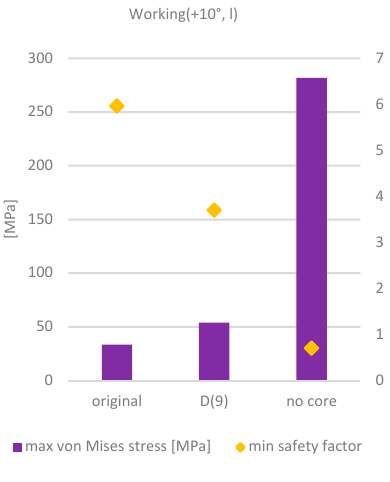
Figure 9. Working (+10°, l ) load case analysis results.